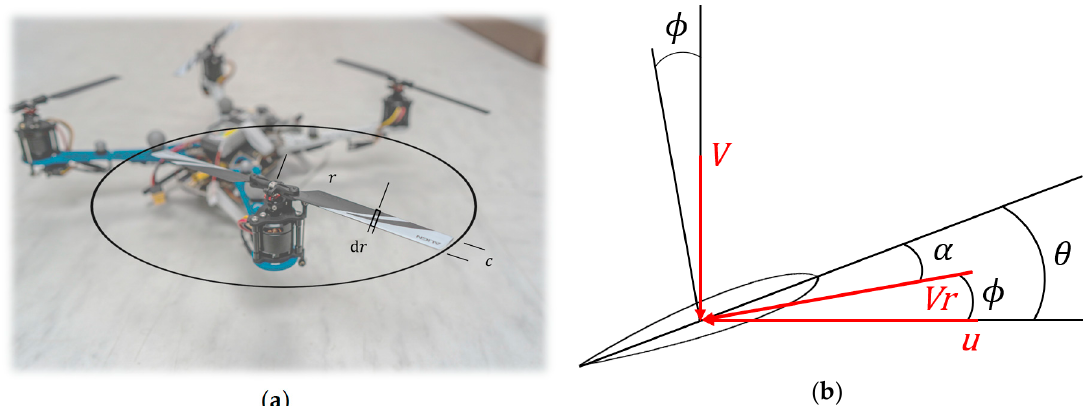
Figure 1. ( a ) Rotation disk of a variable-pitch propeller (VPP) system; ( b ) diagram to explain the blade element momentum (BEM) theory.